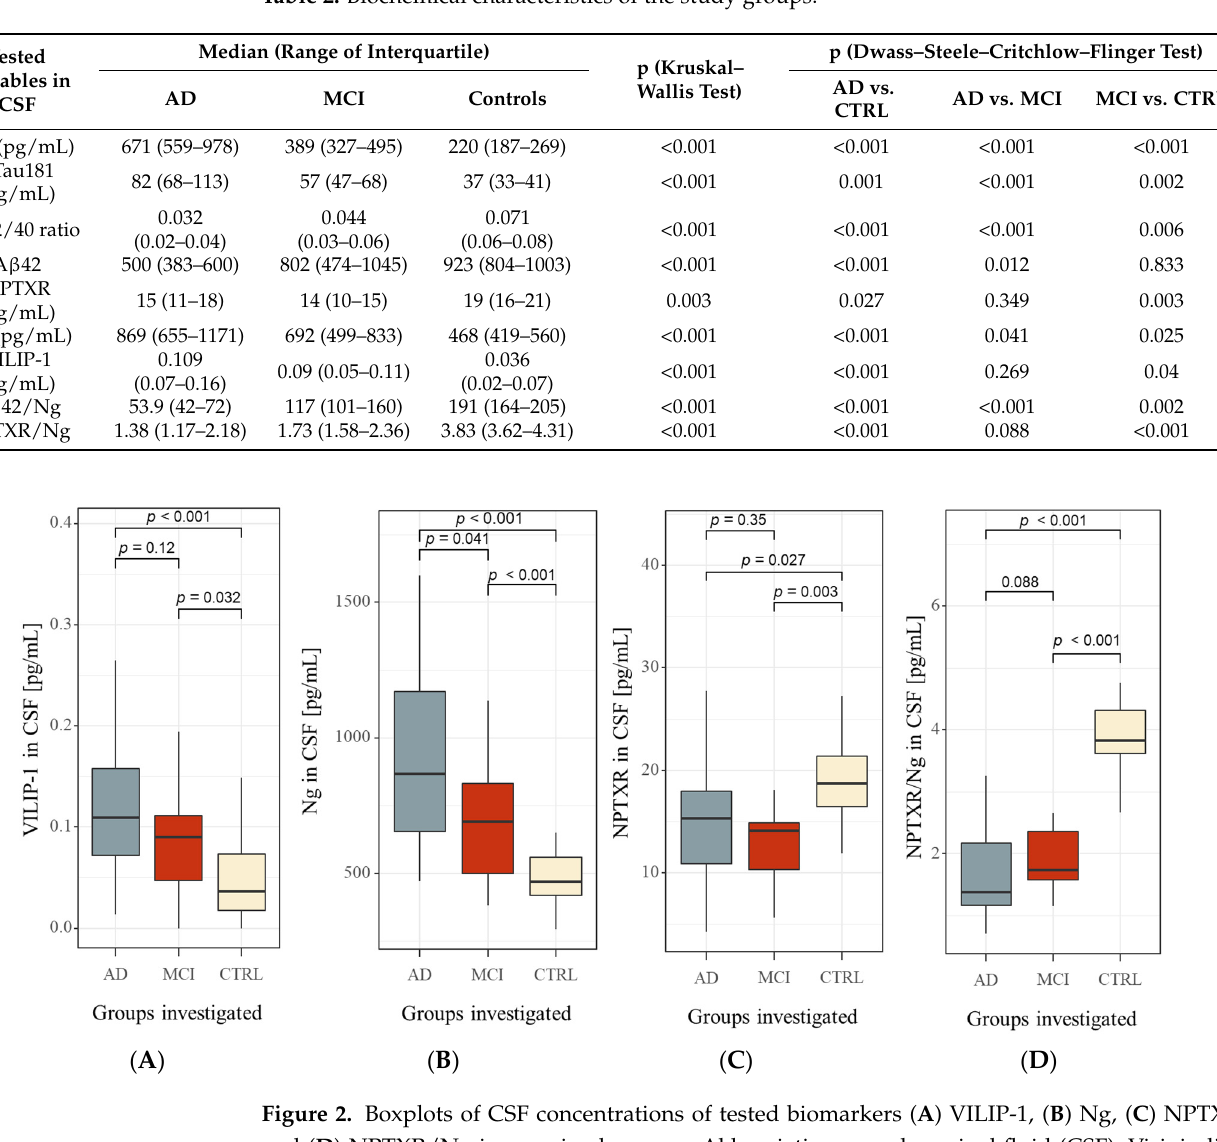
Table 2. Biochemical characteristics of the study groups.